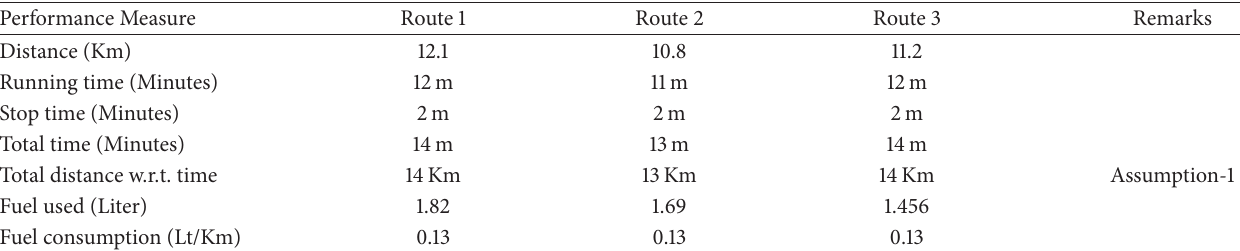
Table 3: Free flow Condition Fuel Consumption.